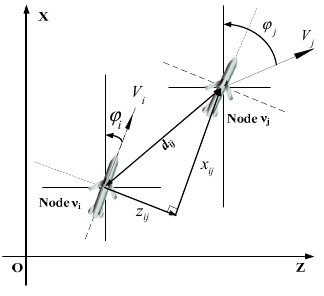
Figure 1. Relative movement between neighboring nodes.